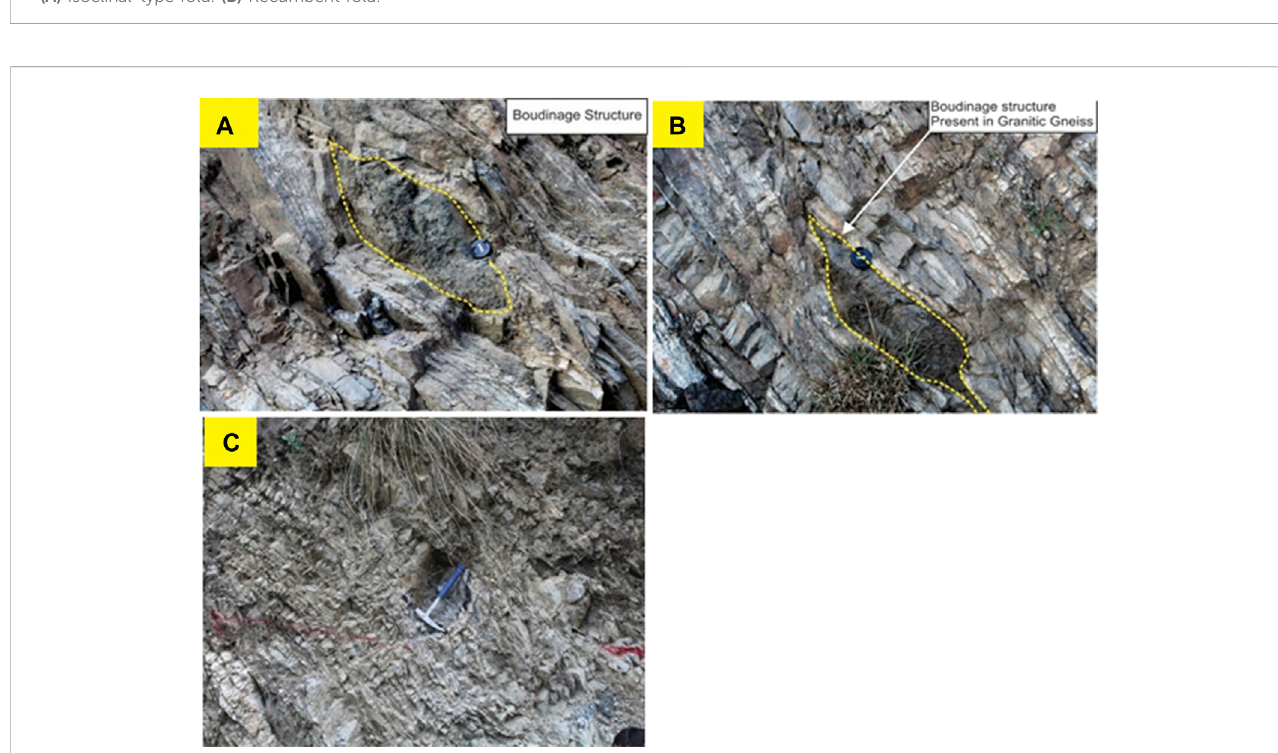
FIGURE 9 (A,B) Boudinage structures in granitic gneiss. (C) Highly deformed and crushed rocks and a boudinage structure.